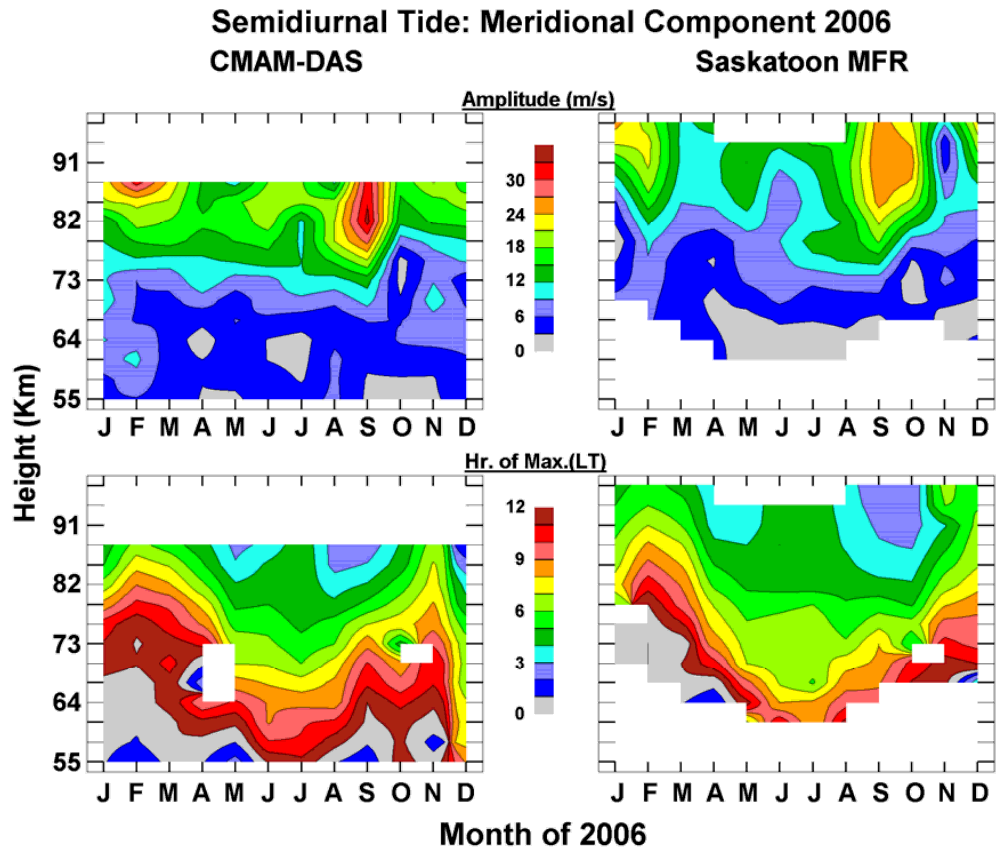
Fig. 2. Contour-plots of amplitudes and phases of the semidiurnal tide [meridional wind component] as functions of height and time: Data for 2006 from the Saskatoon MF radar and the model CMAM-DAS at this location (105W, 52N) have been used. Please see the text for any additional details.